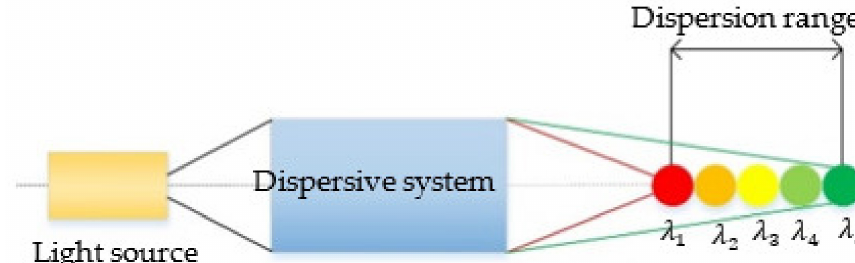
Figure 1. Principle of spectral decoding technology.